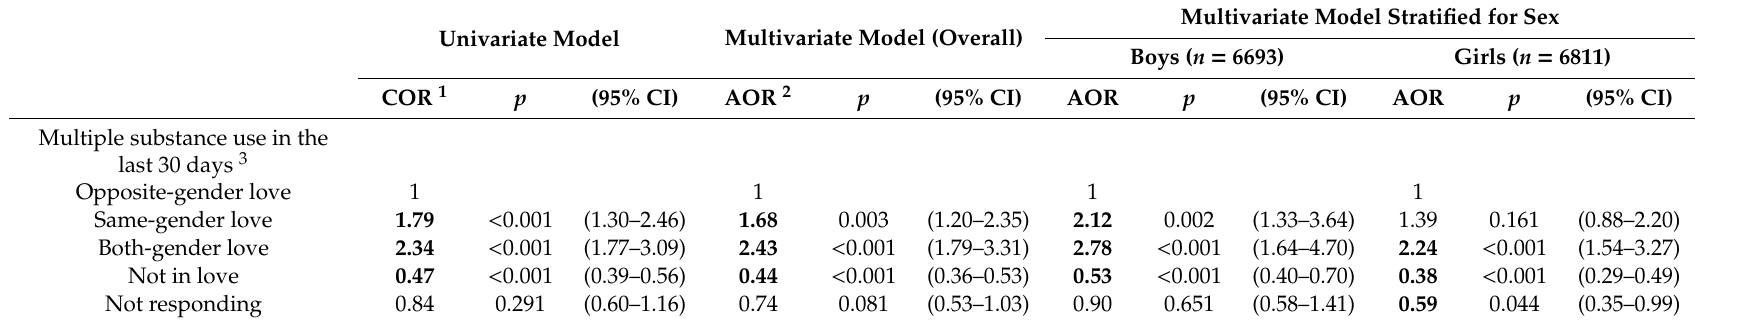
Table 4. Crude and adjusted odds for multiple substance use, overall and by sex ( n = 13,580). Univariate Model Multivariate Model